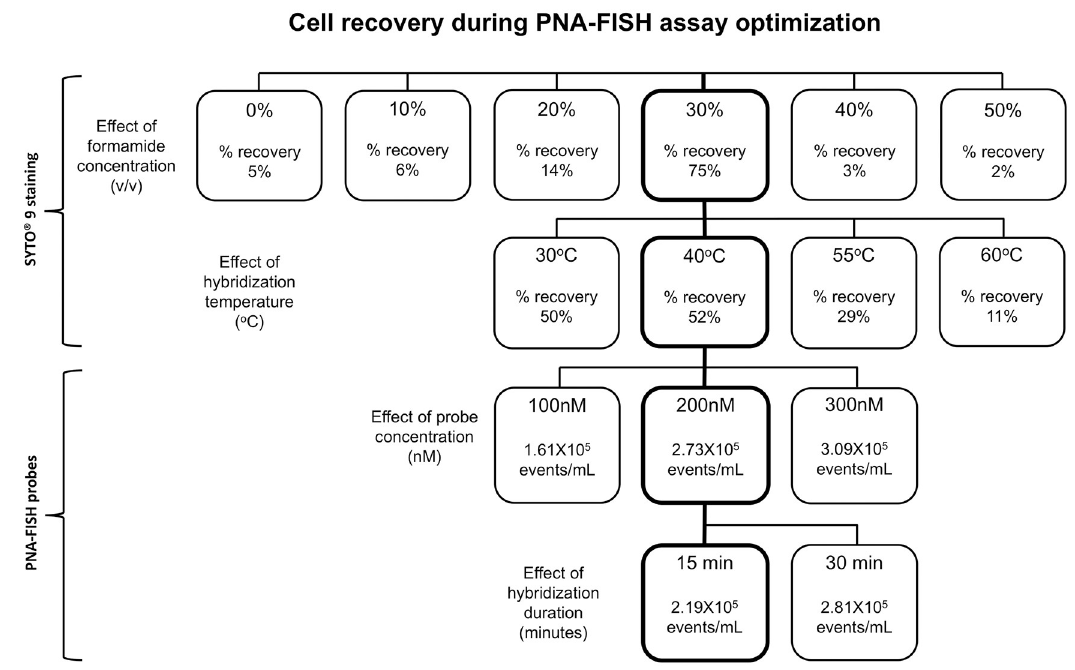
Fig 3. PNA-FISH assay optimisation flowchart using pure bacterial culture. Four optimisation protocols were performed one of each for formamide concentration, hybridization temperature, probe concentration, and hybridization duration. In the first two protocols (top rows), SYTO 9 was used to determine changes in the overall bacterial population subjected to variations in formamide concentrations and temperature. Initially, varying concentrations of formamide were added to bacterial suspensions containing equal amounts of bacteria followed by incubation at 40˚C for 15 minutes prior to staining with SYTO 9. The highest bacterial recovery of 75% was achieved with 30% formamide (v/v, thick frame) compared to other treated and untreated samples. This formamide concentration (30%) was selected for subsequent experiment in which bacterial cells were exposed to varied hybridization temperatures from 30˚C to 60˚C (second row). The best result with 52% bacterial cell recovery was obtained at 40˚C (thick frame). For the last two optimisation steps, PNA-FISH probe was used in hybridization buffer containing 30% formamide at 40˚C (third and fourth rows). In the third row, three different probe concentrations from 100 to 300 nM were tested by PNA-FISH. The probe concentration of 200 nM turned out to be optimal (thick frame) since no significant increase in hybridisation signal was observed when the probe concentration was elevated to 300 nM. Eventually, hybridization duration of 15 minutes was determined as optimal since the majority of the hybridization positive events were detected in the first 15 minutes. The squares with thick frames stacked vertically indicate optimised hybridization conditions applied to all subsequent experiments.